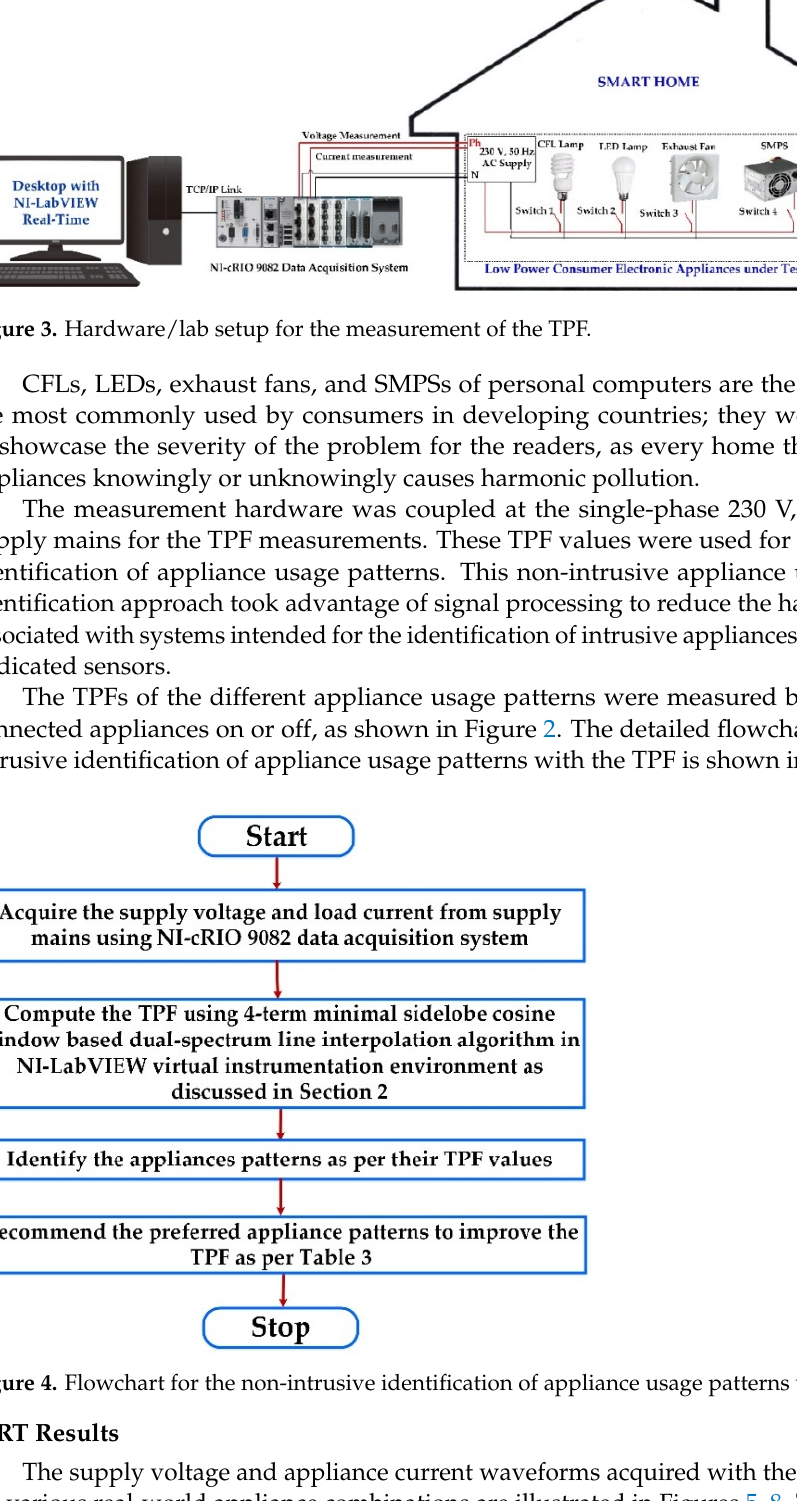
Figure 4. Flowchart for the non-intrusive identification of appliance usage patterns with the TPF.